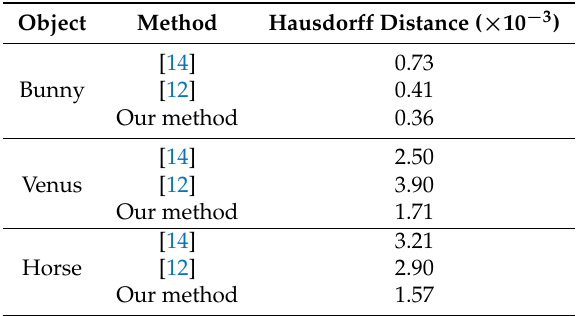
Table 15. Imperceptibility comparison with Cho’s [14], and Medimegh’s [12] schemes measured in terms of HD.